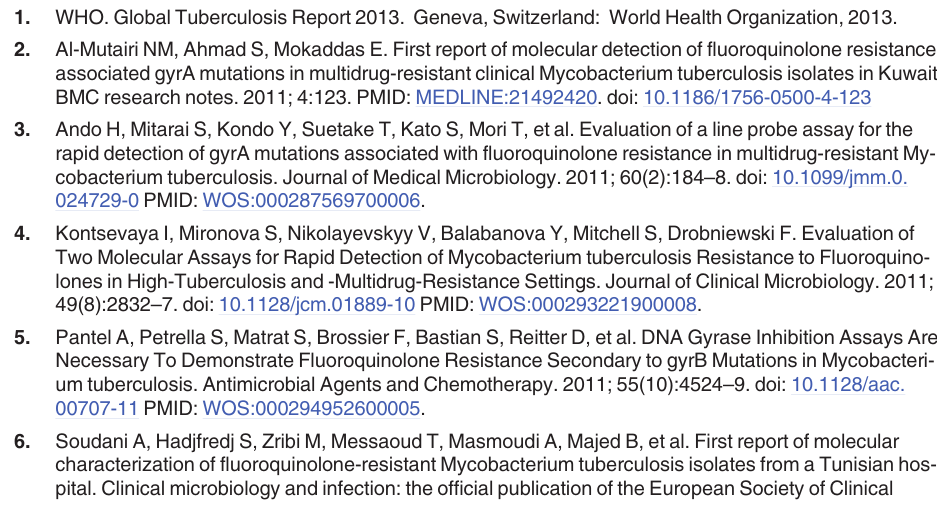
S3 Table. Cumulative Frequencies of the Most Frequently Occurring Double